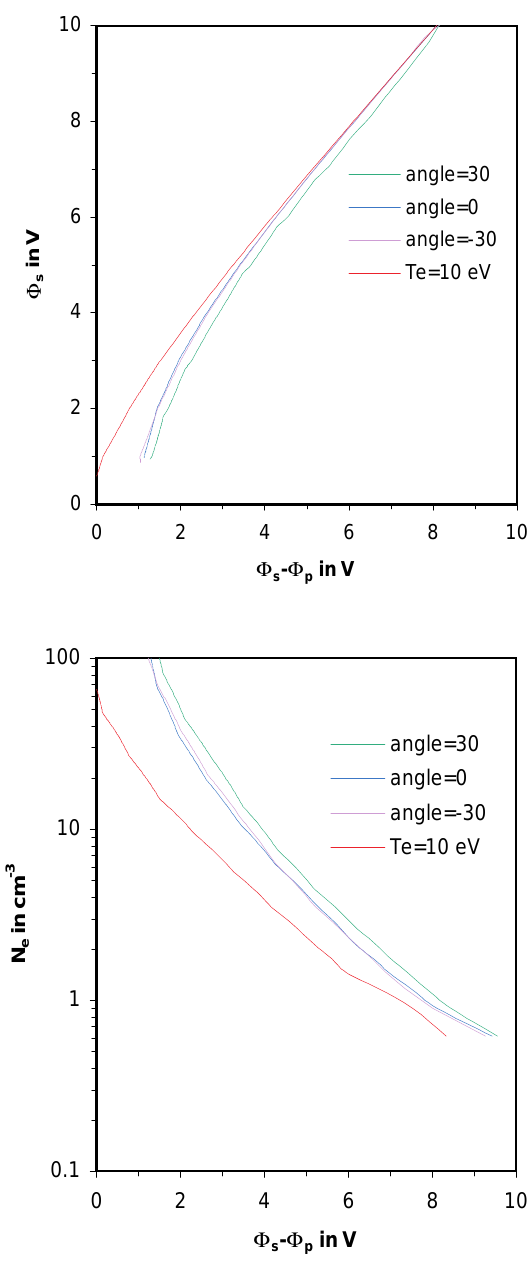
Fig. 12. Relations for B 0 = 1 µ T between: (top) the spacecraft- probe potential measured by IESP and the spacecraft potential with respect to the plasma, (bottom) the spacecraft-probe potential mea- sured by IESP and the plasma density. The plotted curves are asso- ciated with the following parameters : T e = 10eV, α = 0 ◦ (red), T e = 1eV, α = − 30 ◦ (purple), T e = 1eV, α = 0 ◦ (blue), and T e = 1eV, α = + 30 ◦